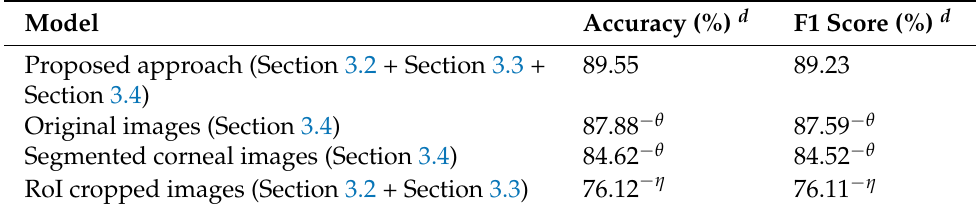
Table 3. Results of ablation study conducted on the proposed